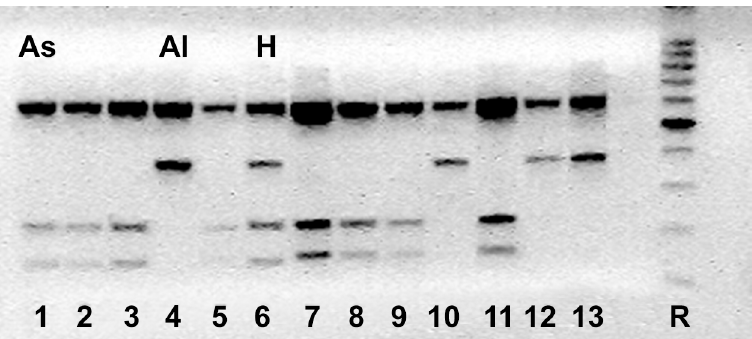
Figure 1. Molecular characterization of Ascaris by PCR-RFLP. A representative gel displaying the RFLP profiles following the digestion of ITS amplicons with restriction endonuclease Hae III. Genotype As: Ascaris suum banding pattern (lanes 1–3,5,7–9,11); genotype Al : A. lumbricoides banding pattern (lanes 4,10,12,13); genotype H: hybrid/heterozygote banding pattern (lane 6); R (right-hand lane): 100bp reference ladder.